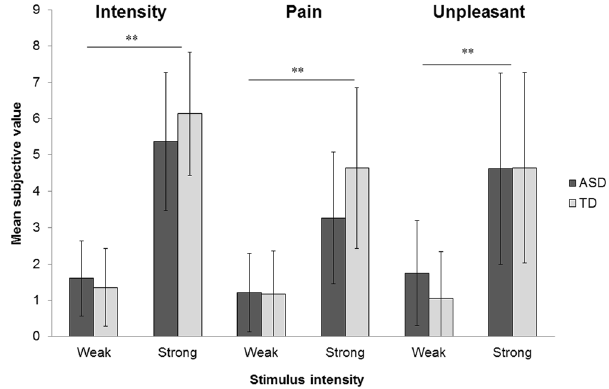
Figure 2. The subjective values for each perception across groups as a function of stimulus intensity. Error bars show SD. ** p < 0.01.